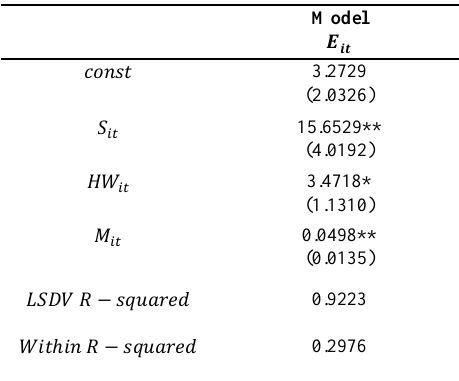
Table 3. Estimation